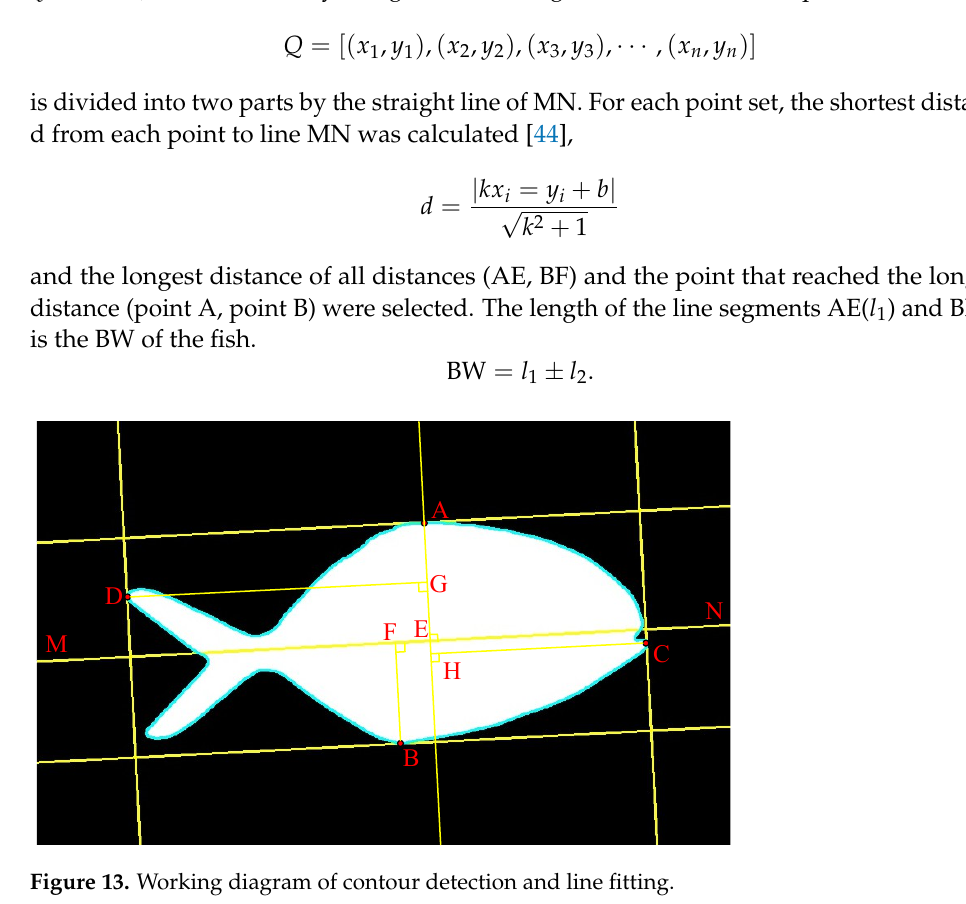
Table 1 Pseudo code description of the line fitting scheme.